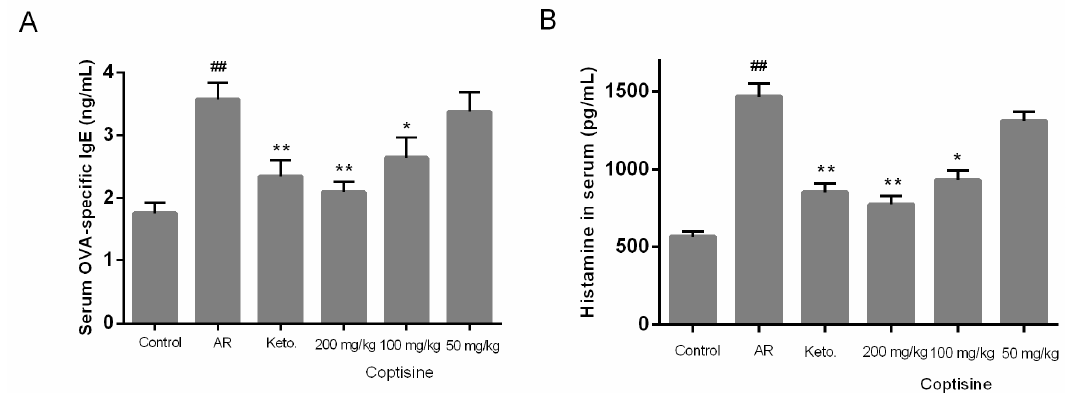
Figure 8. Effect of coptisine on OVA-specific IgE, histamine levels in OVA induced AR mice. The level of OVA-specific IgE ( A ); The level of histamine ( B ) All data were expressed as the mean ± SE. ## p < 0.01 were compared to the normal group; * p < 0.05 and ** p < 0.01 were compared to AR mice, n = 10/group.